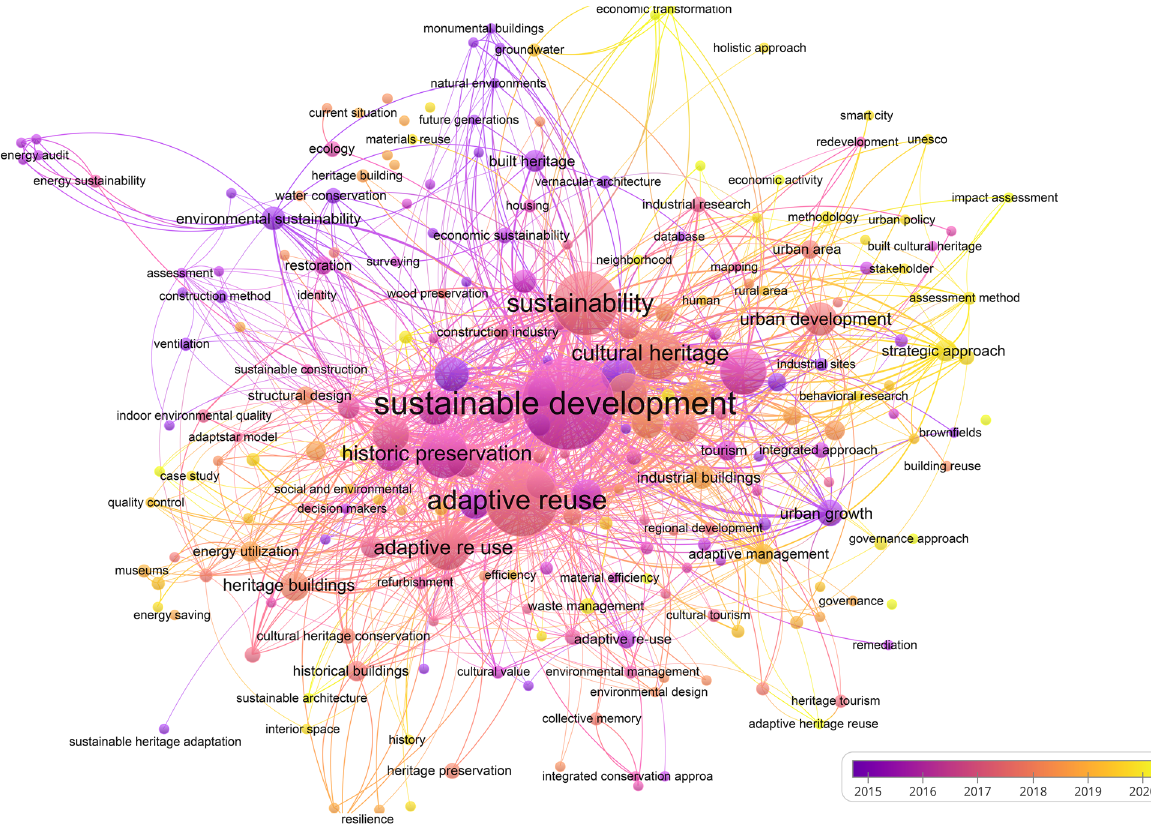
Fig. 2 Research topics and progress concerning sustainable development, architectural heritage, and adaptive reuse from 2010 to 2020. (Source: The author